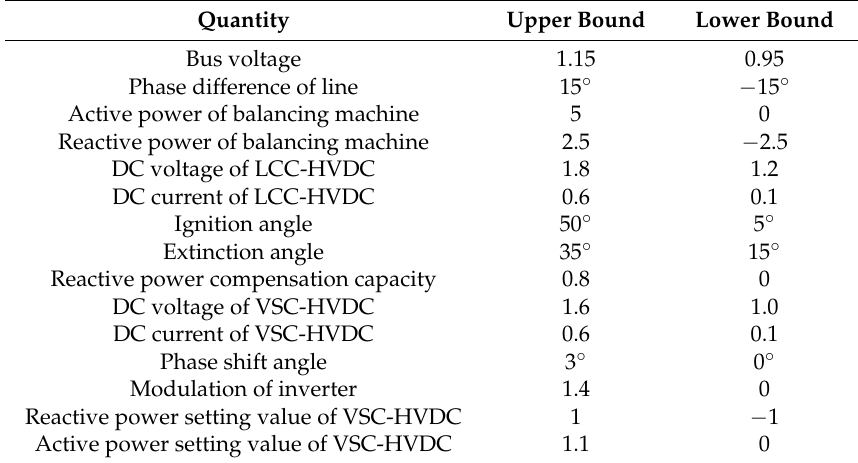
Table 3. The values of upper and lower limitations of constraint.